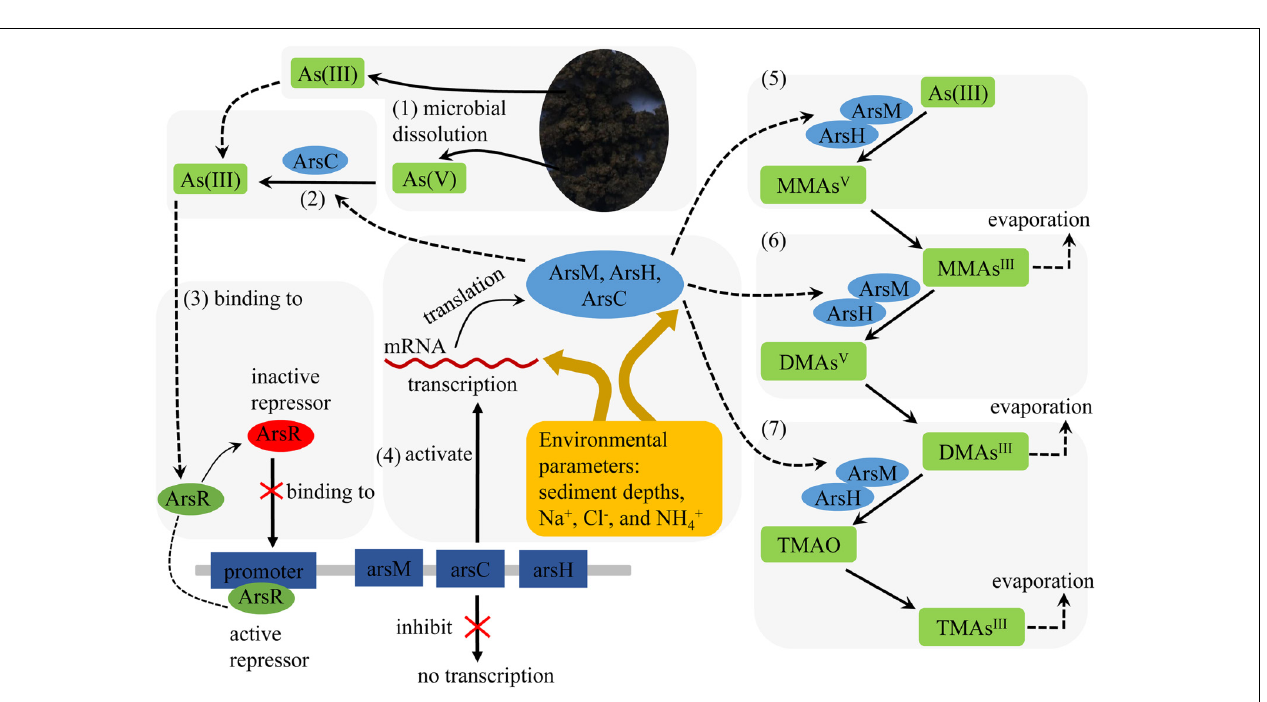
FIGURE 7 | Schematic representation of the metabolic pathway for arsenic biomethylation reactions in the arsenic-rich